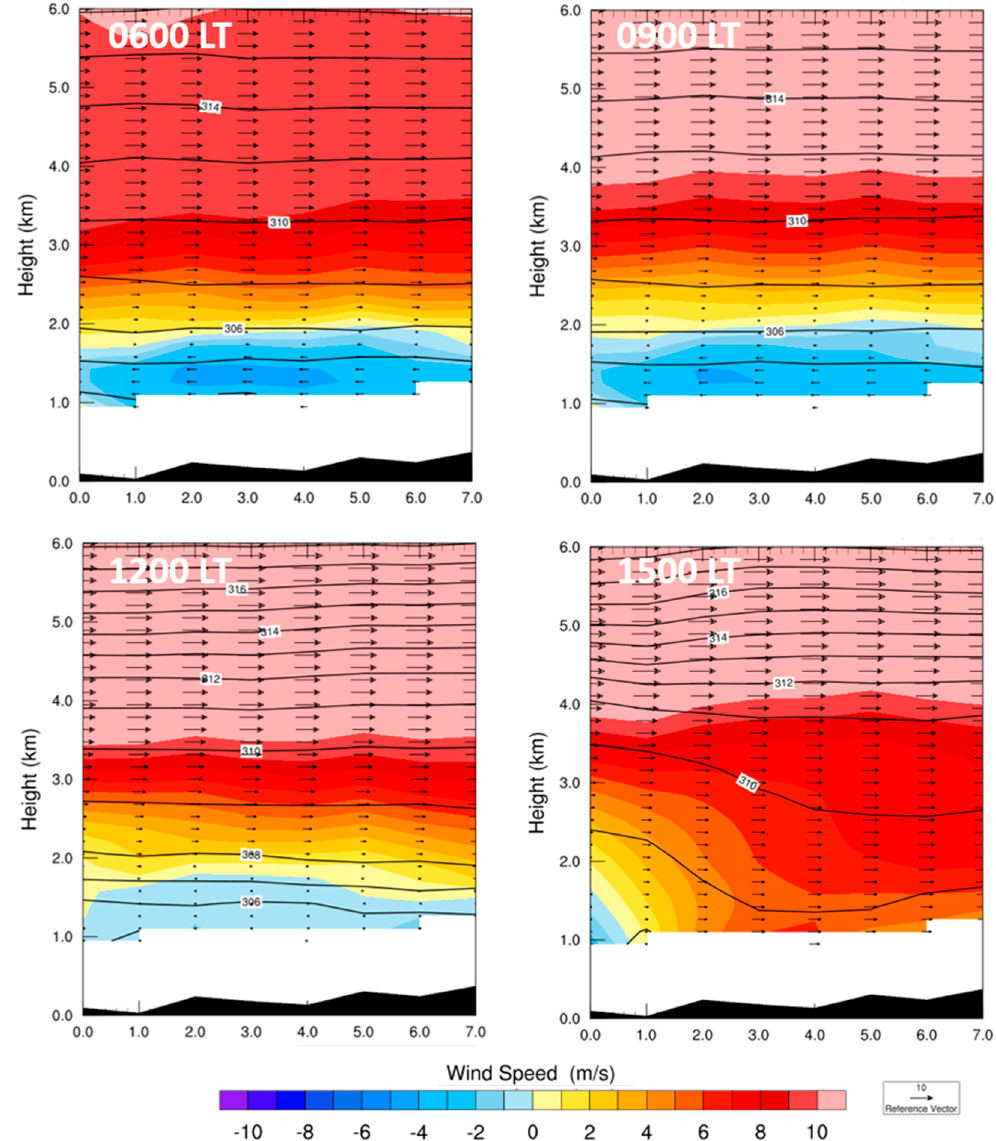
Figure 14. Along-valley vertical profiles of wind and potential temperature simulated in the 4 km domain for event day 17 August. Wind vectors indicate wind in the x - z plane. Wind speed is the u-component of the wind; negative values indicate easterly flow. Only the lowest 6 km are shown.